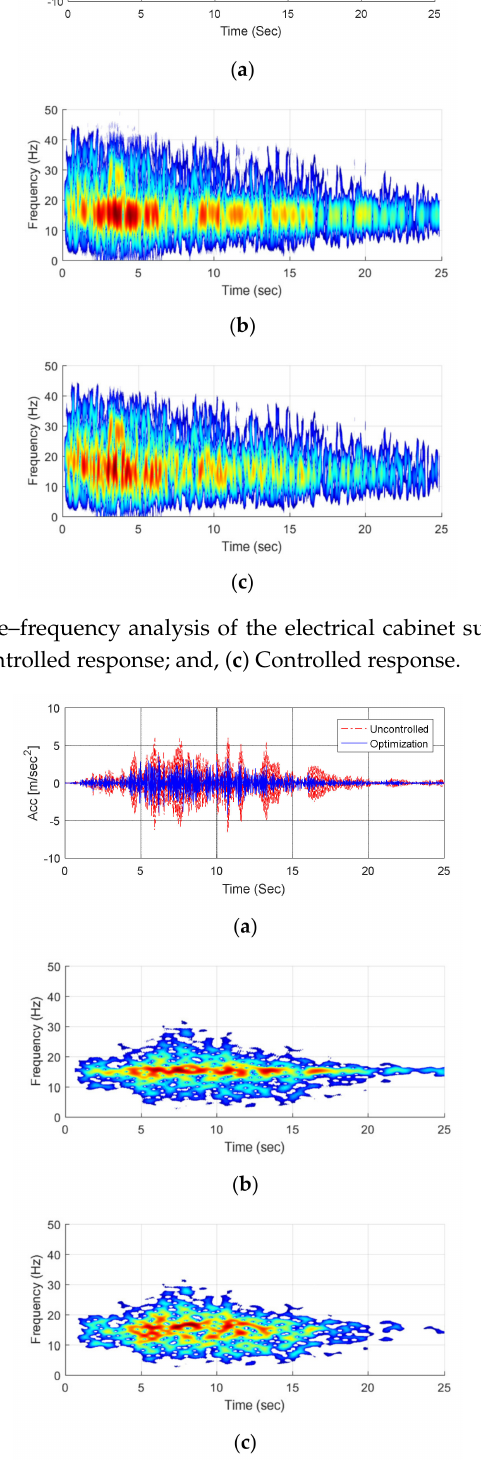
Figure 30. Results of time–frequency analysis of the electrical cabinet subjected to Imperial Valley-06: ( a ) Time history; ( b ) Uncontrolled response; and, ( c ) Controlled